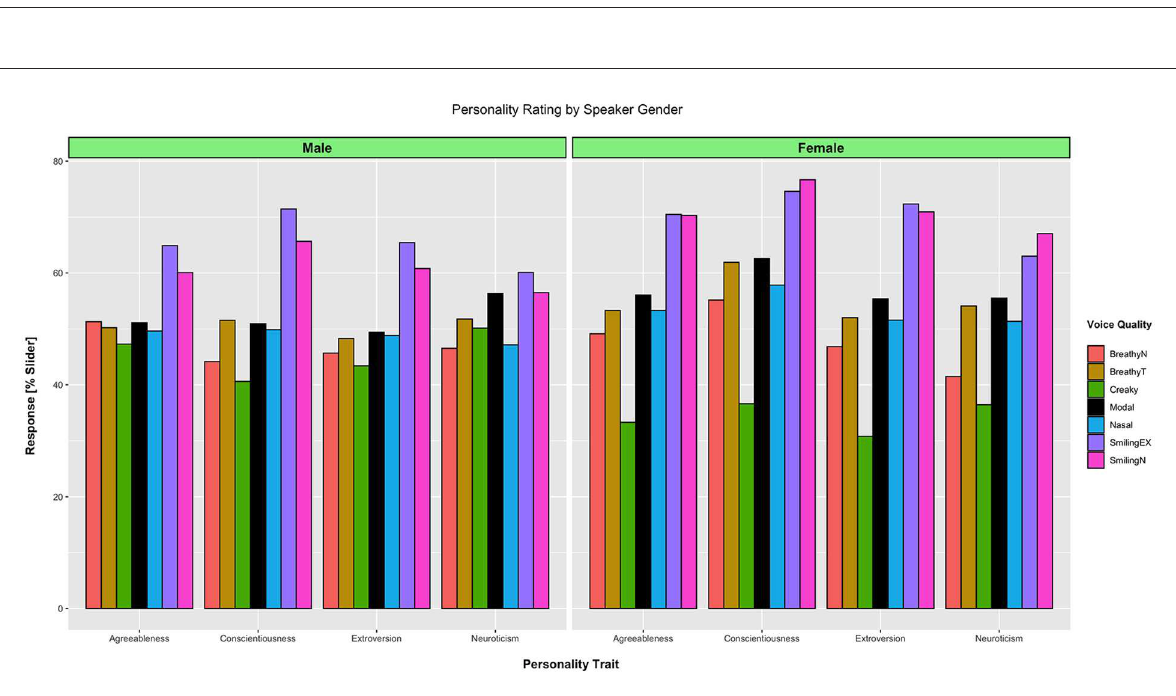
FIGURE5 Mean ratings over all listeners comparing male speakers (left) vs. female speakers (right) productions, split by vocal quality. See Figure 3 for a description of axes and